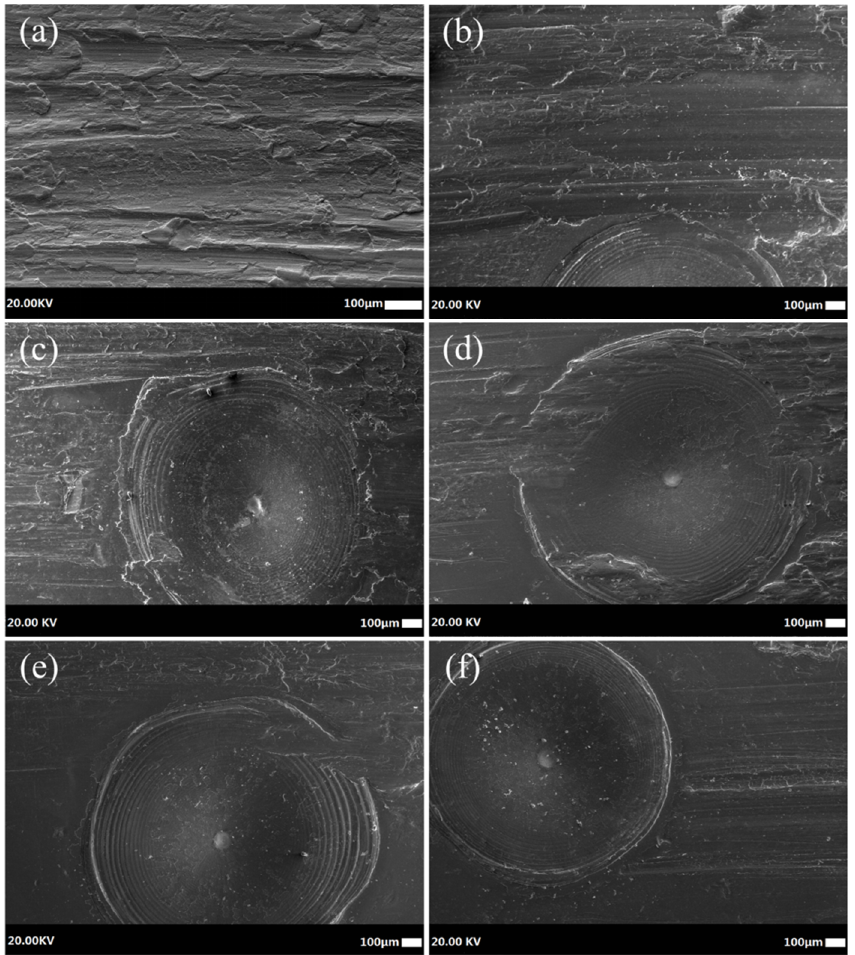
Figure 10. SEM images of wear scars for samples with different texture densities after a 45 min sliding test was performed under conditions of 100 N and 300 rpm: ( a ) smooth, ( b ) texture density = 4%, ( c ) texture density = 8%, ( d ) texture density = 13%, ( e ) texture density = 18%, and ( f ) texture density = 30%.